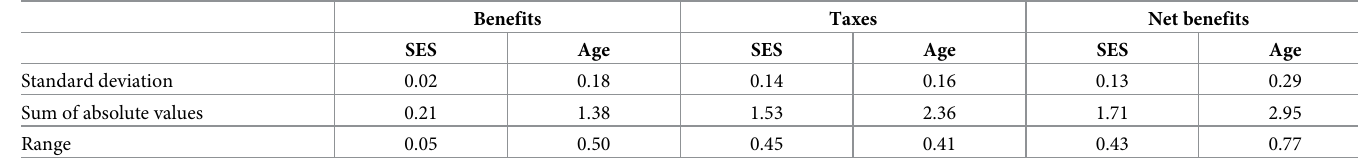
Table 1. Sum of absolute values, range, and standard deviation of the average marginal effects of age and SES in models of benefits, taxes, and net